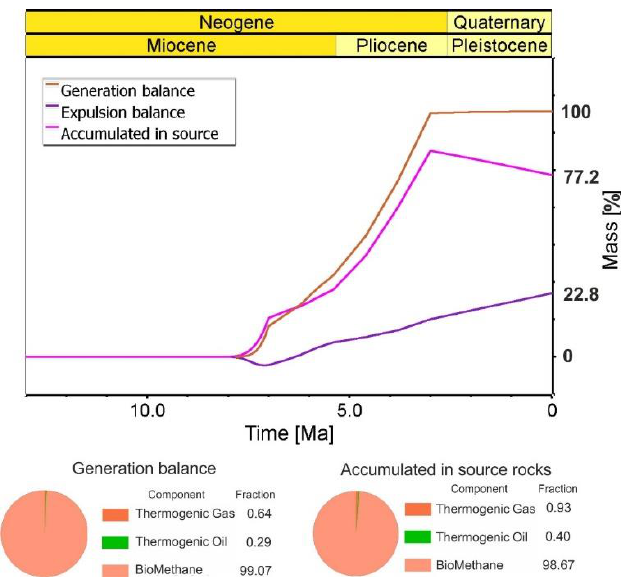
Figure 18. Progress of hydrocarbon generation, expulsion, and accumulation within overburden of deltaic sediments (Complex 6) (plot) and proportion between generated, expelled, and accumulated masses of hydrocarbons; below: Composition pie charts of generated ( left ) and accumulated ( right ) components evidencing similar proportions between biogenic and thermogenic gases generated and accumulated within mudstones – claystones.